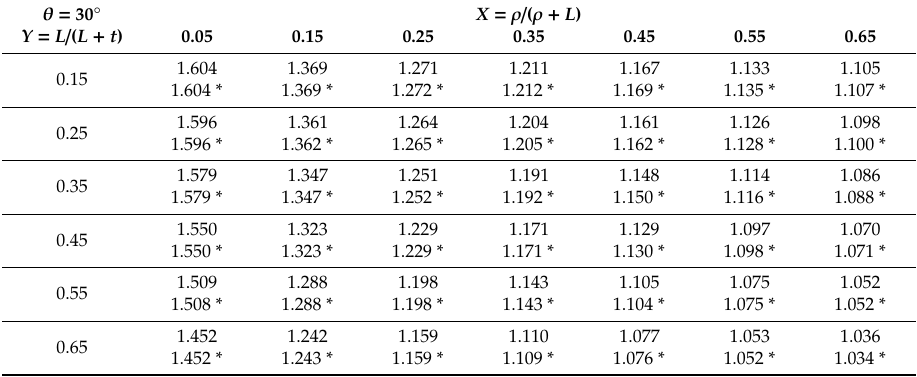
Table 5. Comparison of SCFs calculated using formula (A3) (*) to the FEM results for a Double-V butt-welded joint subjected to shearing load, where θ = 30 ◦